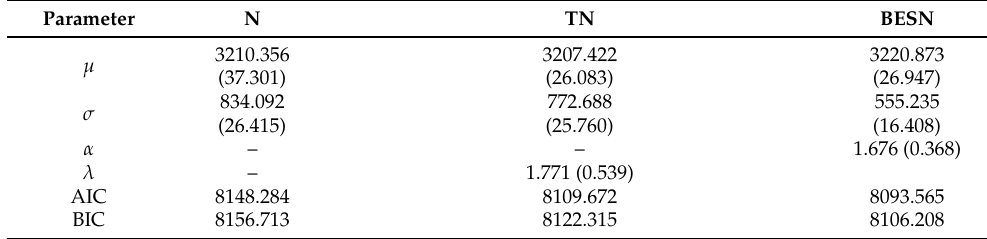
Table 6. Parameter estimates and SE for the N, TN and BESN models.